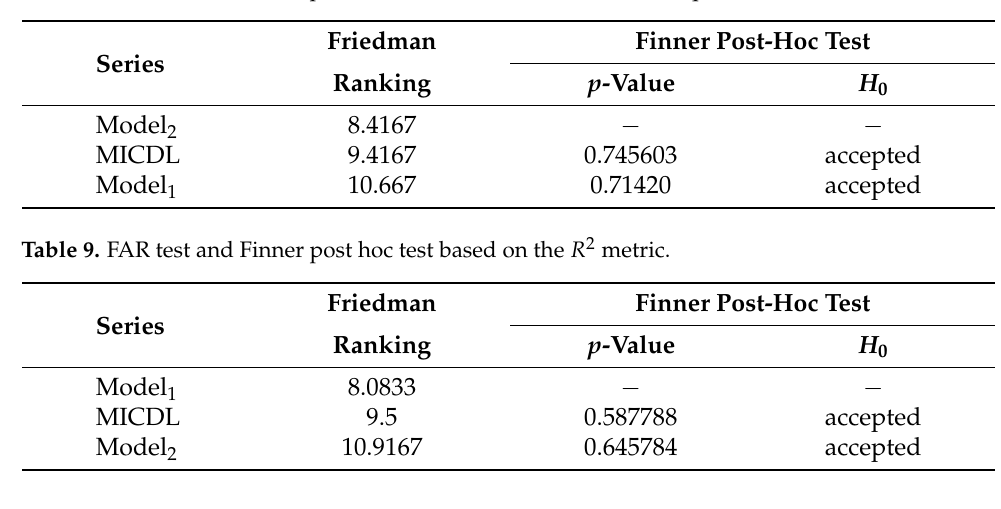
Table 8. FAR test and Finner post hoc test based on the root mean square error (RMSE) metric.